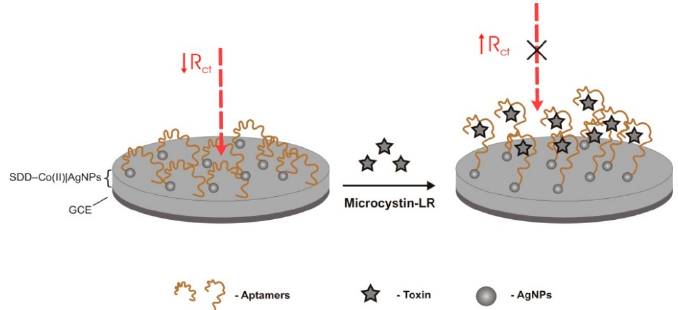
Figure 6. Electrochemical aptasensor for microcystin-LR (MC-LR) detection using a glassy carbon electrode (GCE) with aptamers self-assembled on a surface of cobalt (II) salicylaldimine metallodendrimer (SDD–Co(II)) doped with silver nanoparticles (AgNPs), by their 5 ′ thiolated end [38]. When aptamer-MC-LR complexes are formed, there is a decrease in the peak current. R ct —charge transfer resistance.